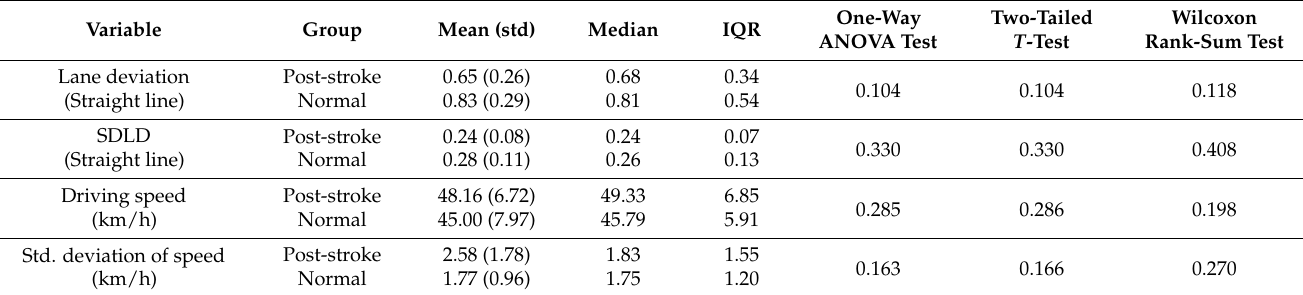
Table 4. Statistical tests of lane keeping performance and speed control in straight line section